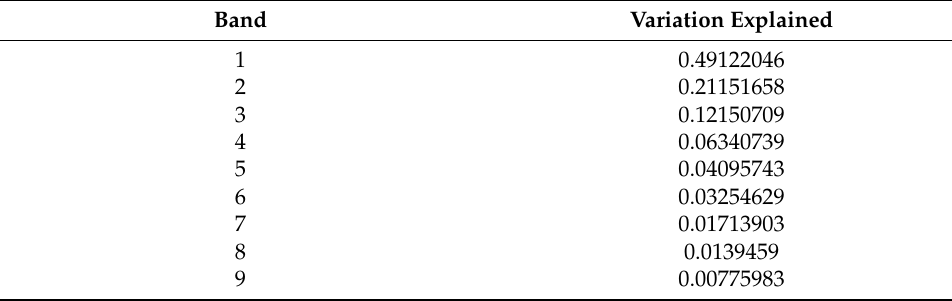
Table A13. ULS PCA band variation explained at 1m grid size.